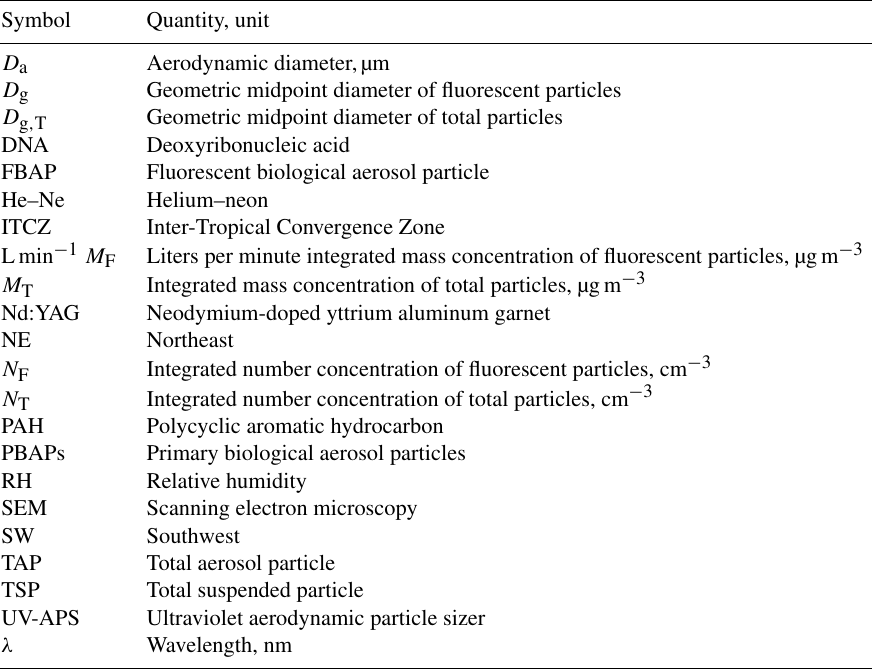
Figure 1. Location of measurement site Munnar (10.09 ◦ N, 77.06 ◦ E; 1605ma.m.s.l. – above mean sea level) located in the Western Ghats mountain range in southern tropical India with 10-day back-trajectories (HYSPLIT, NOAA-ARL GDAS1 model; start height 50m above ground level; start time 23:30LT, local time) illustrating the distinct and contrasting wind patterns during two contrasting seasons: southwest monsoon season (representative month July) and winter season (representative month January) when field measurement campaigns were carried out. It is evident that the predominant wind pattern during the southwest monsoon season was westerly/southwesterly, bringing the clean marine influx as also evident from the wind rose diagram shown in inset (a) . The meteorological parameters were recorded using the weather station installed close to the inlet system (b) . The inlet system prepared for sampling the air using an ultraviolet aerodynamic particle sizer (UV-APS) for bioaerosol number size distribution measurement (c) . The map shown is color-coded by topography (meters) and trajectories are color-coded by atmospheric pressure level (hPa). Table 1. List of frequently used acronyms and symbols with